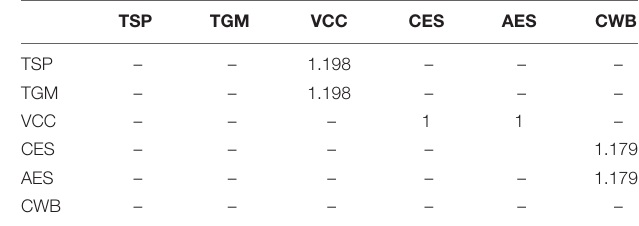
TABLE 4 | Test for common method bias (Inner